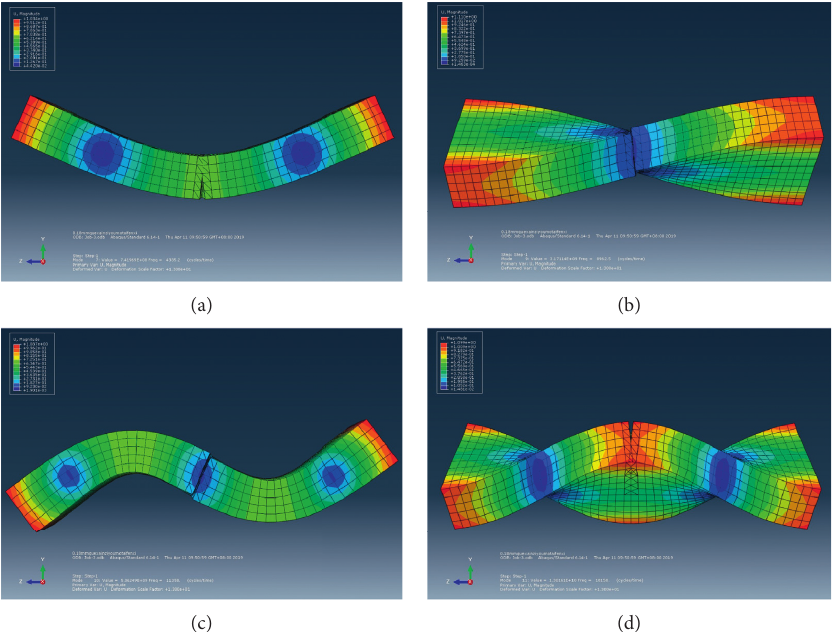
Figure 3: Modal analysis of wire-cut notched metal specimens. (a) The first mode. (b) The second mode. (c) The third mode. (d) The fourth mode.